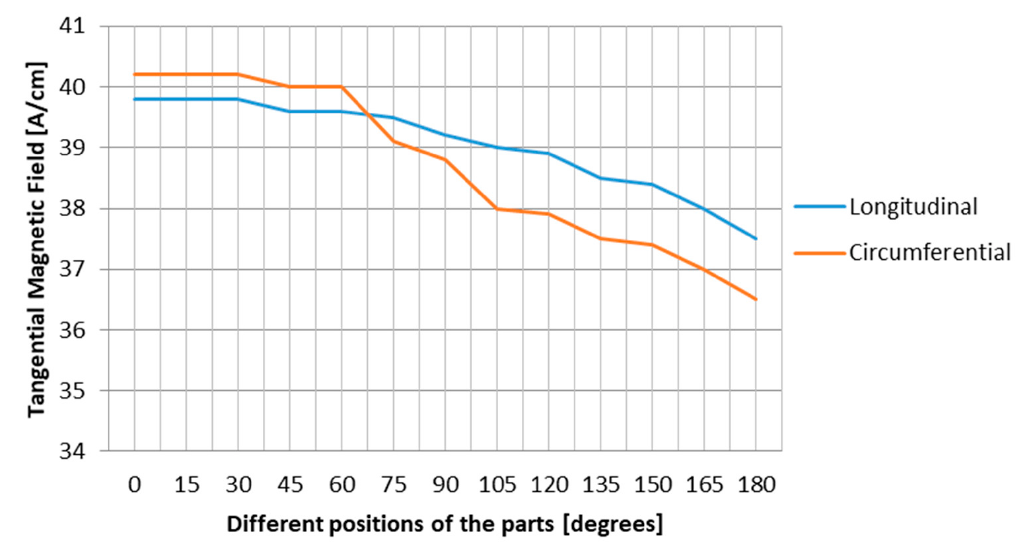
Figure 6. Changes in the magnetic field for the part with central conductor.